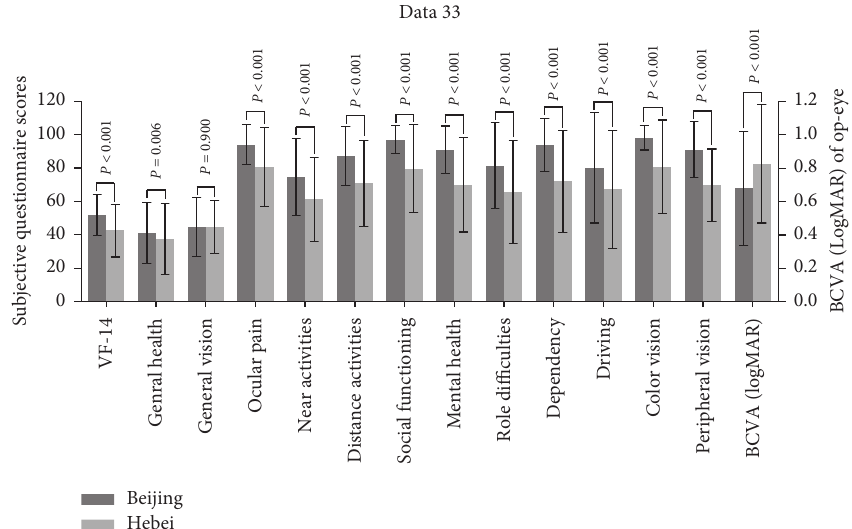
Figure 1: Difference in VF-14, NEI-VFQ-25, and BCVA of op-eye between Beijing and Hebei. VF-14, Visual Function Index-14; NEI-VFQ- 25, 25-item National Eye Institute Visual Functioning Questionnaire; BCVA, best-corrected visual acuity. Error bar represents standard deviation.